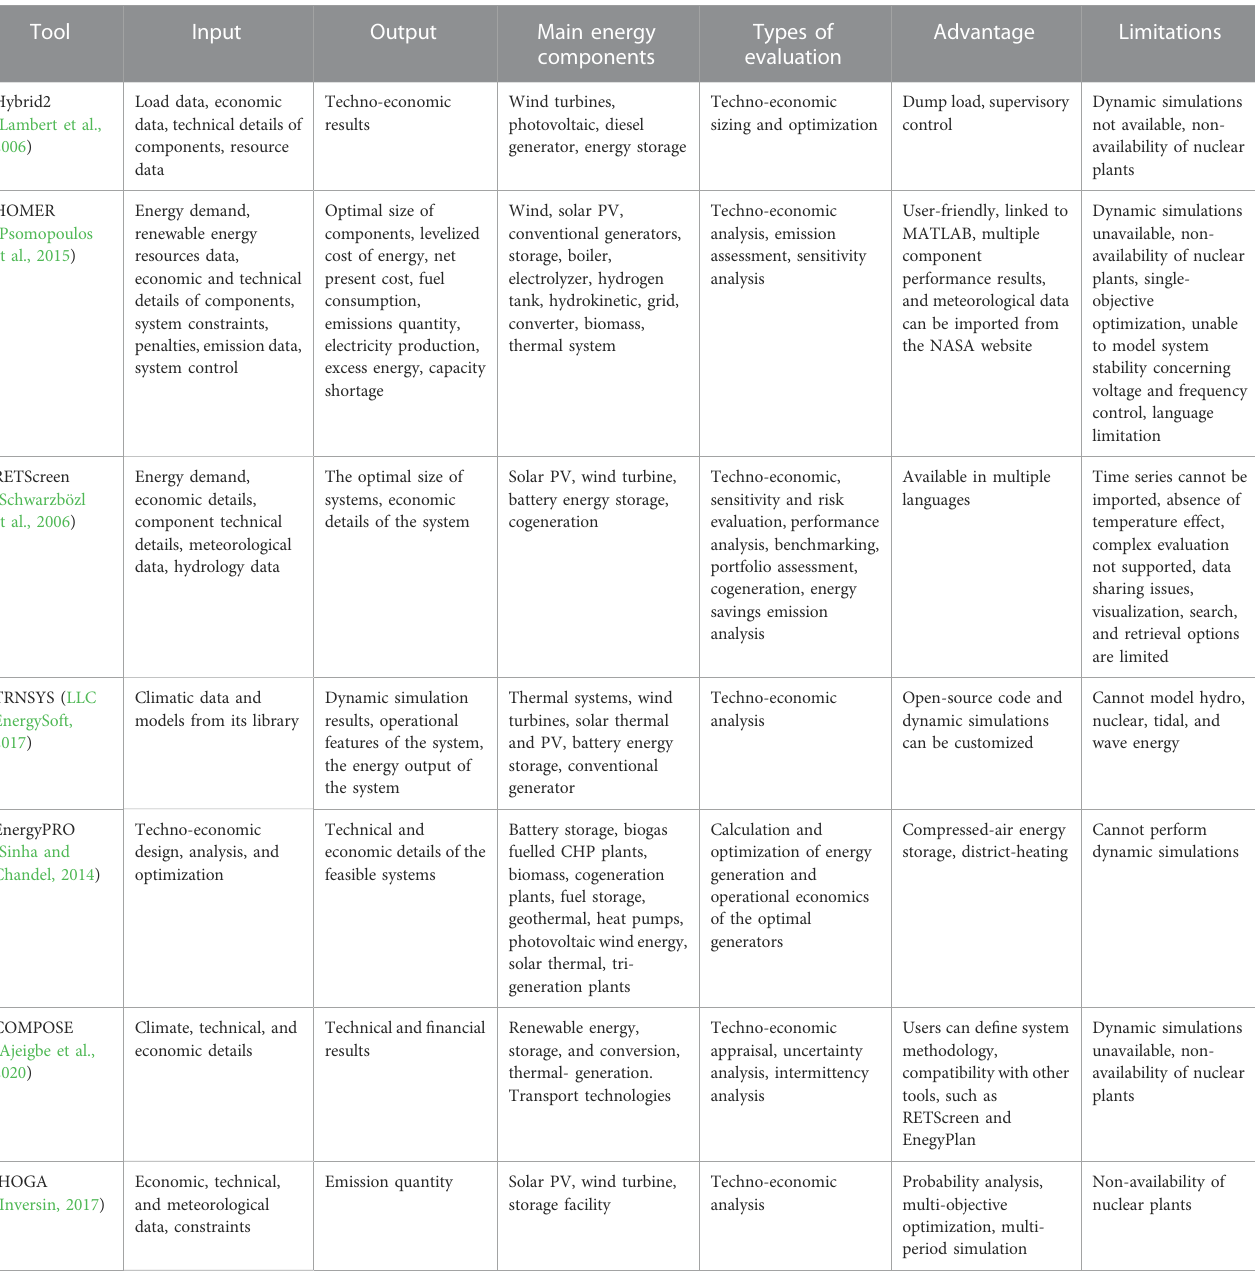
TABLE 3 Comparison of prominent mini-grid design tools.